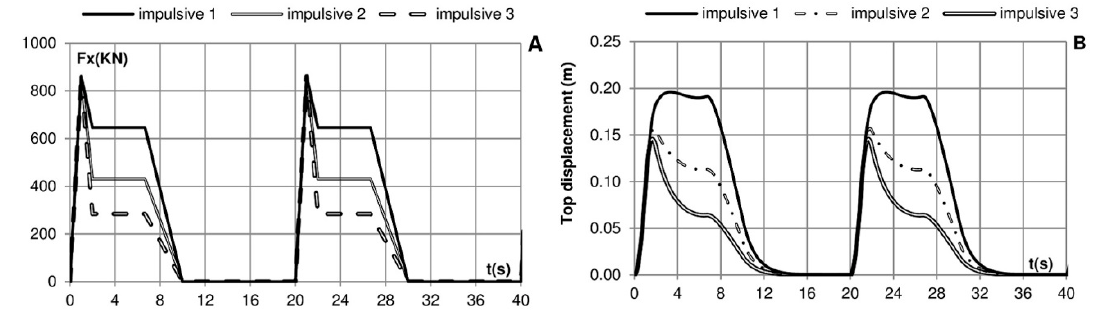
Figure 15. Tip factor influence: ( A ) shape of the signals; ( B ) movements on the top of the foundation. 2 cycles.